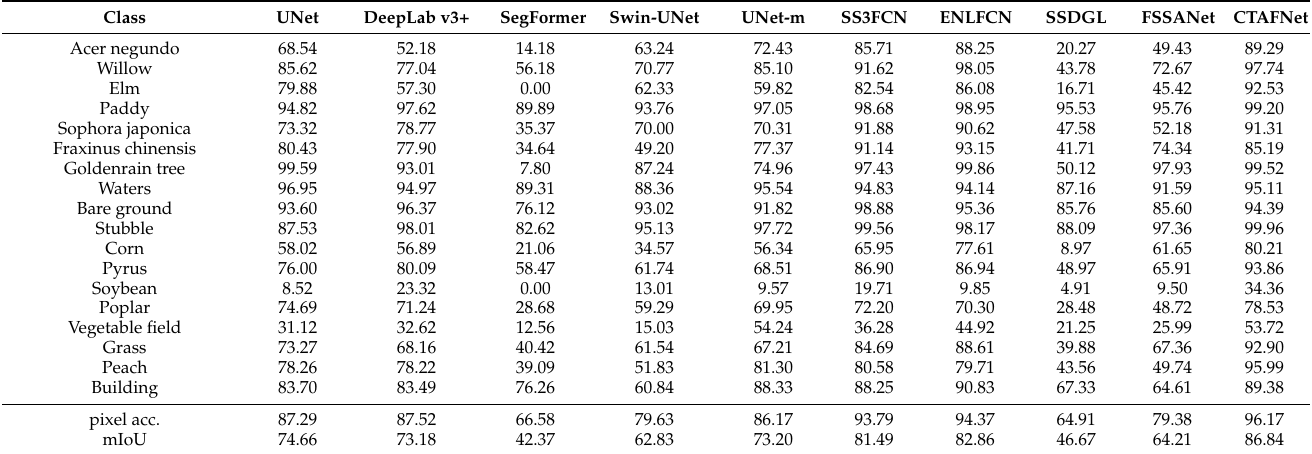
Table 7. Classification results for the Xiongan test